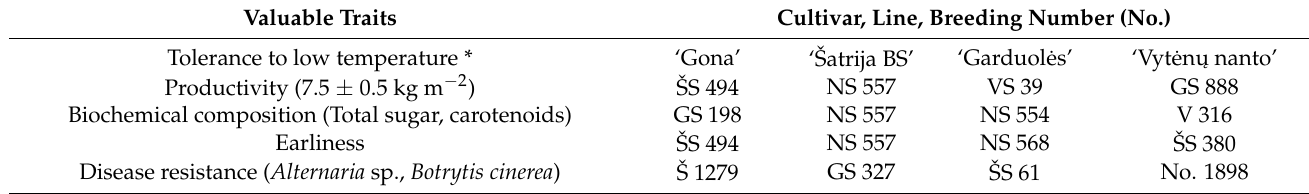
Table 4. Parental material from the carrot national and adapted genetic resources. Valuable Traits Cultivar, Line, Breeding Number